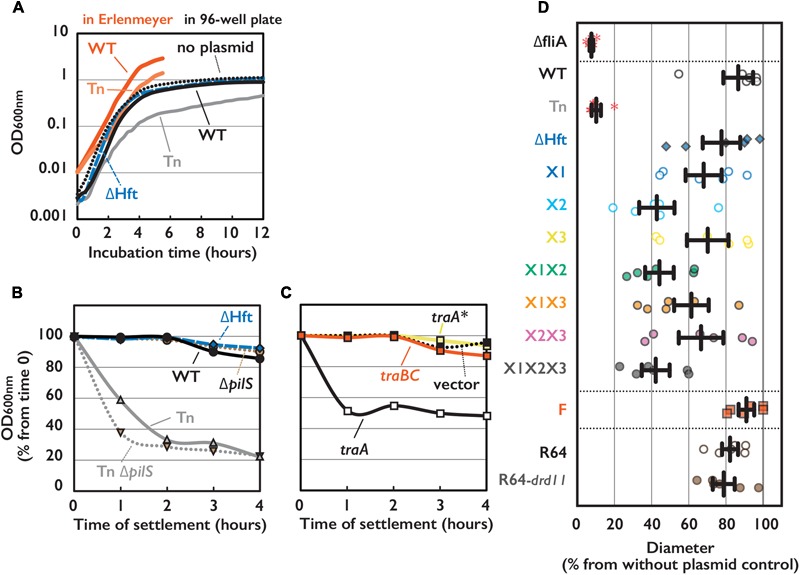
Phenotypes of E. coli cells harboring conjugative plasmid. (A) Cell growth of E. coli strain harboring indicated plasmid measured by OD 600 nm with either conventional spectrometer or 96-well plate reader. (B,C) Sedimentation phenotype measured by OD 600 nm of culture supernatant settled on bench for indicated time. E. coli cells harboring WT or mutant of pESBL as indicated (B) or WT pESBL and an extra plasmid indicated for overexpression (C). Average of at least 3 independent experiments were shown. (D) Motility phenotype measured by diameter of expansion on soft agar plate. Results of 6 independent experiments along with the mean and standard deviations were shown. ΔfliA mutant without plasmid was used for the negative control. Red asterisks indicate no motility.